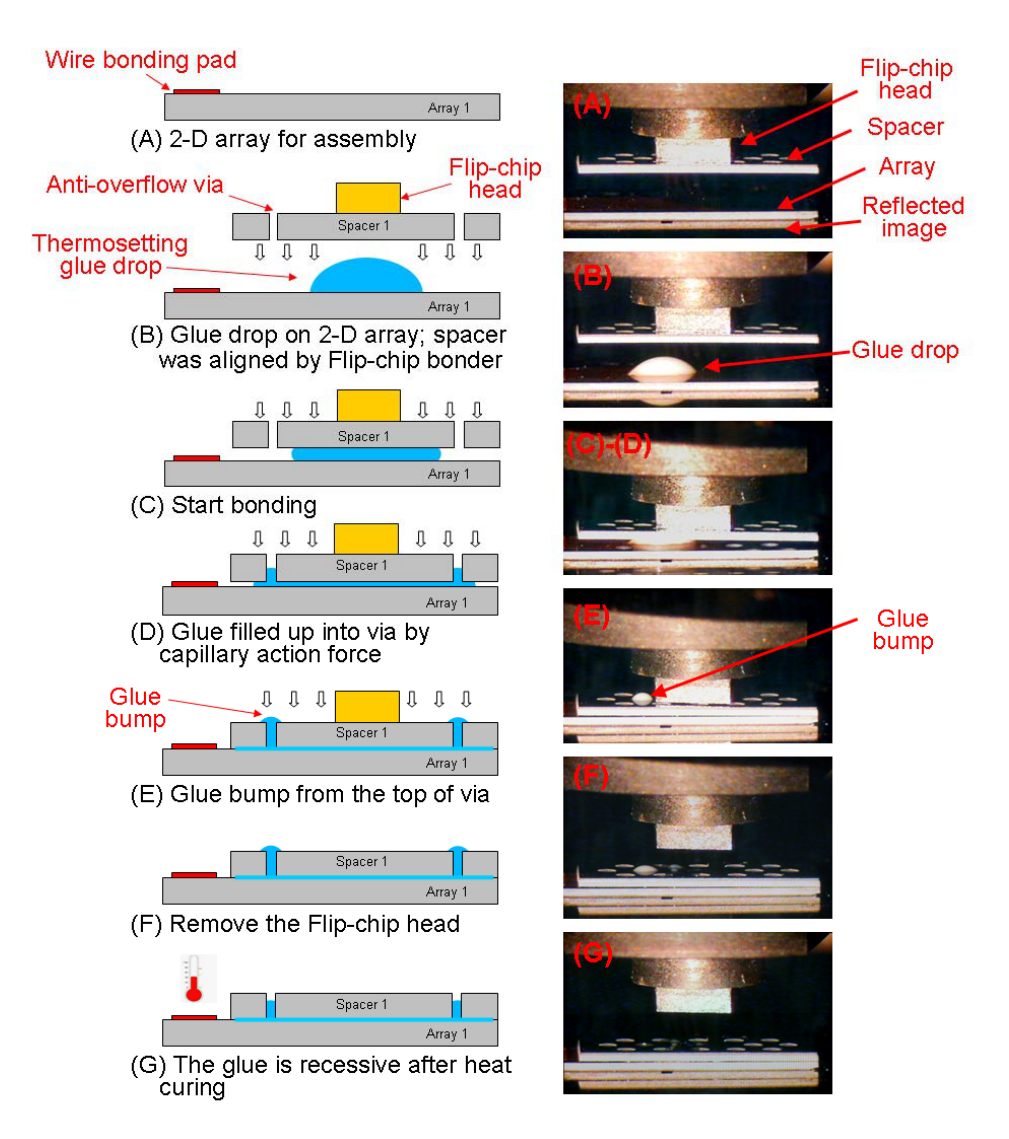
Figure 3. The proposed assembly anti-flow mechanism process and related practical